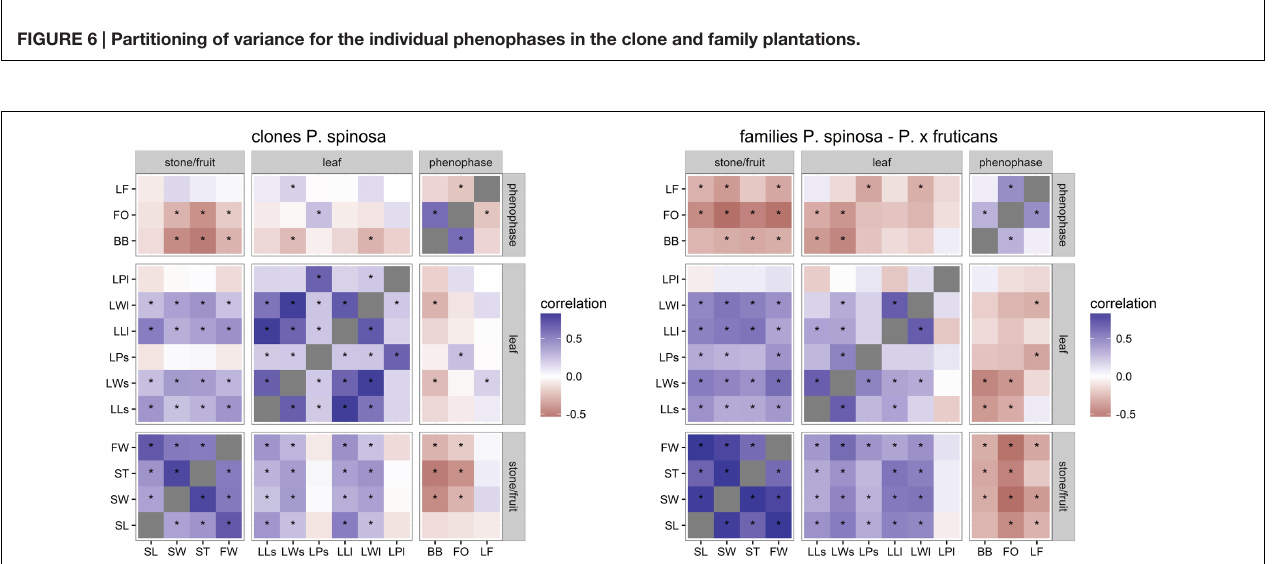
FIGURE 7 | Heat map displaying pairwise correlations between all measured and scored traits for the clone and family plantations. Significant correlations ( P value < 0.05) are indicated with an asterisk. Trait abbreviations are in Tables 2 and 3 .